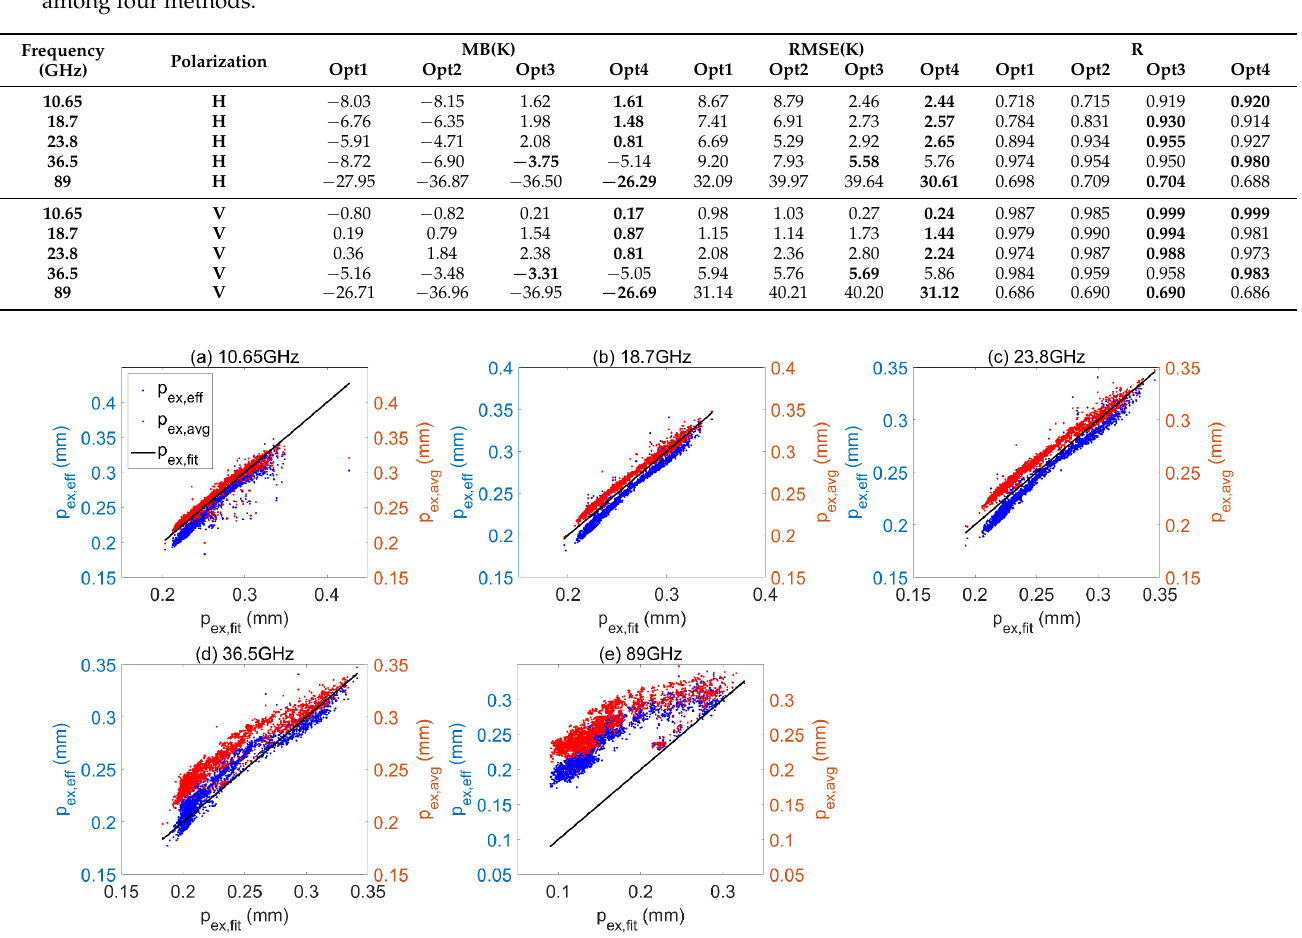
Figure 10. Comparison of effective exponential correlation length ( p ex,eff , in blue dots) used in Option 3 and average exponential correlation length ( p ex,avg , in red dots) used in Option 4 at different frequencies using fitted exponential correlation length ( p ex,fit ) as the reference: ( a ) 10.65GHz; ( b ) 18.7GHz; ( c ) 23.8GHz; ( d ) 36.5GHz; and ( e ) 89GHz.